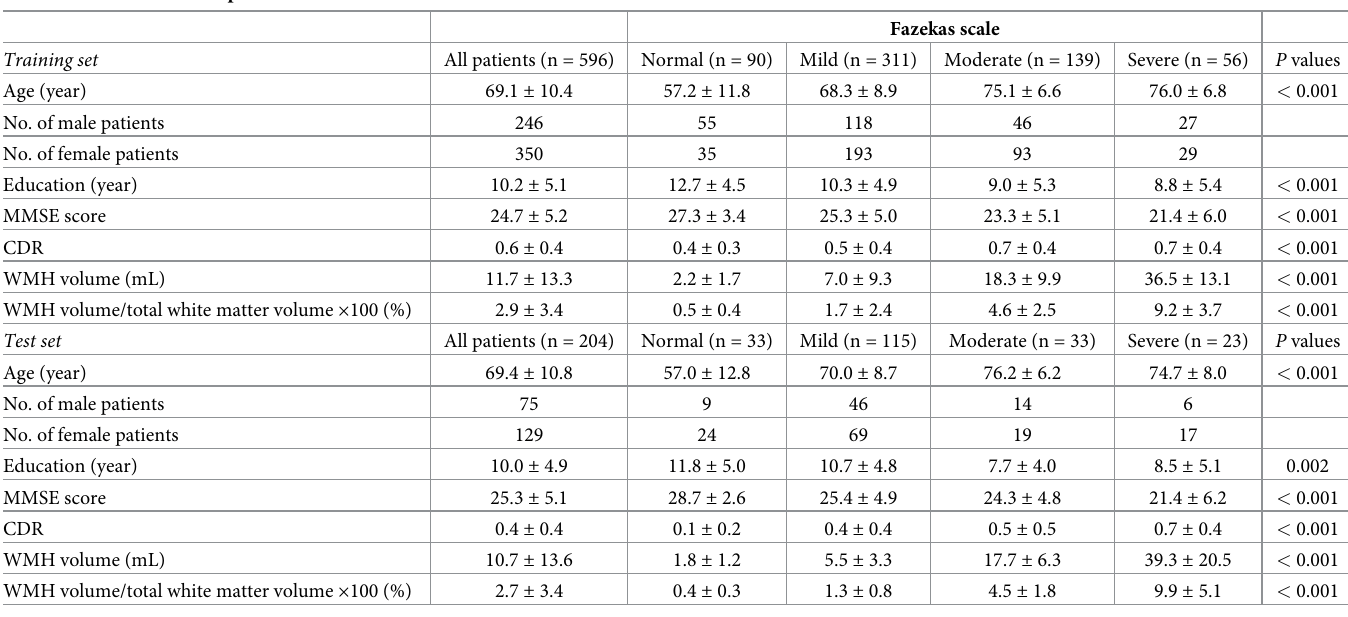
Table 1. Characteristics of patients based on the Fazekas scale.